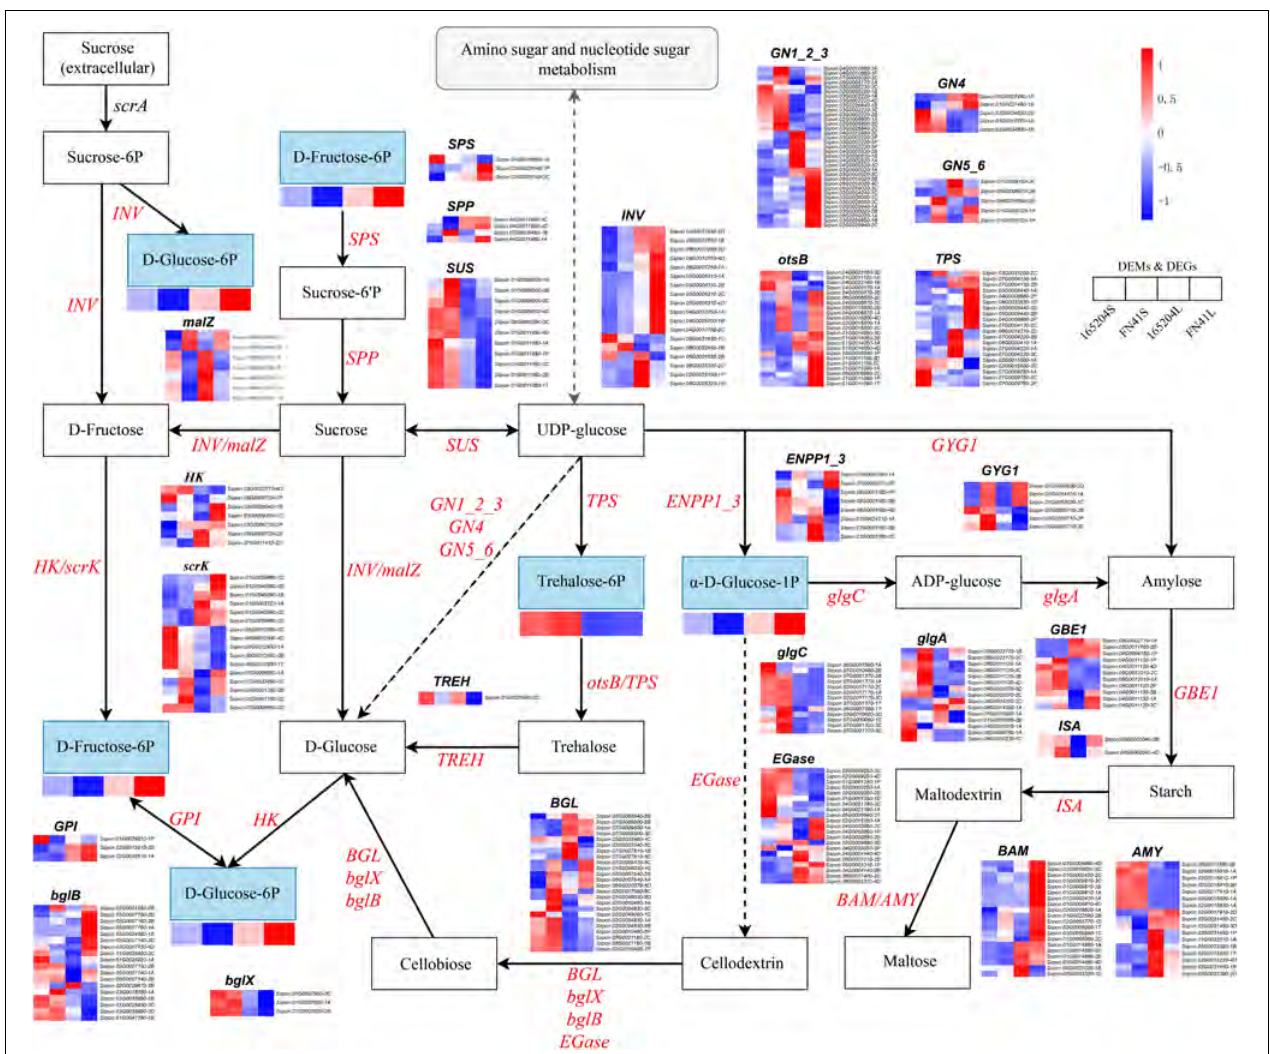
FIGURE 10 | Diagram of starch and sucrose metabolism pathway with their related DEGs and DEMs. SPS, sucrose phosphate synthase; SPS, sucrose phosphatase; SUS, sucrose synthase; INV, invertase; HK, hexokinase; scrK, phosphofructokinase; non-significant DEGs are shown in black. The solid line indicates the metabolic reactions in only one step. The dash line presents more than one step of the metabolic